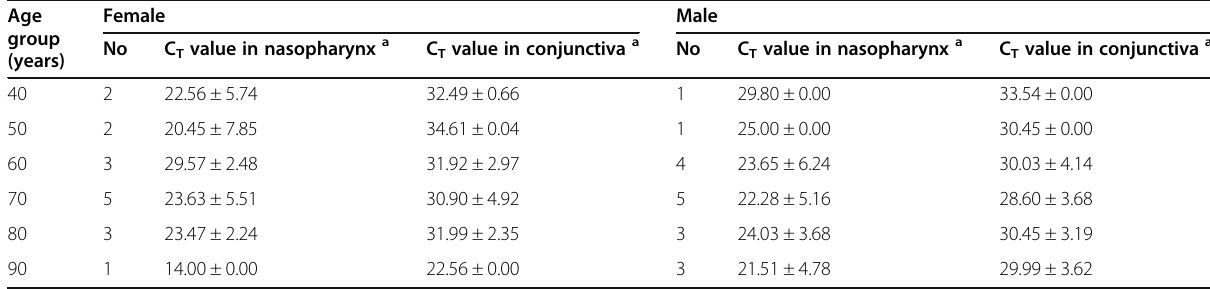
Table 4 The cycle threshold (C T ) values from patients with positive PCR test in conjunctival sac swab stratified by age and